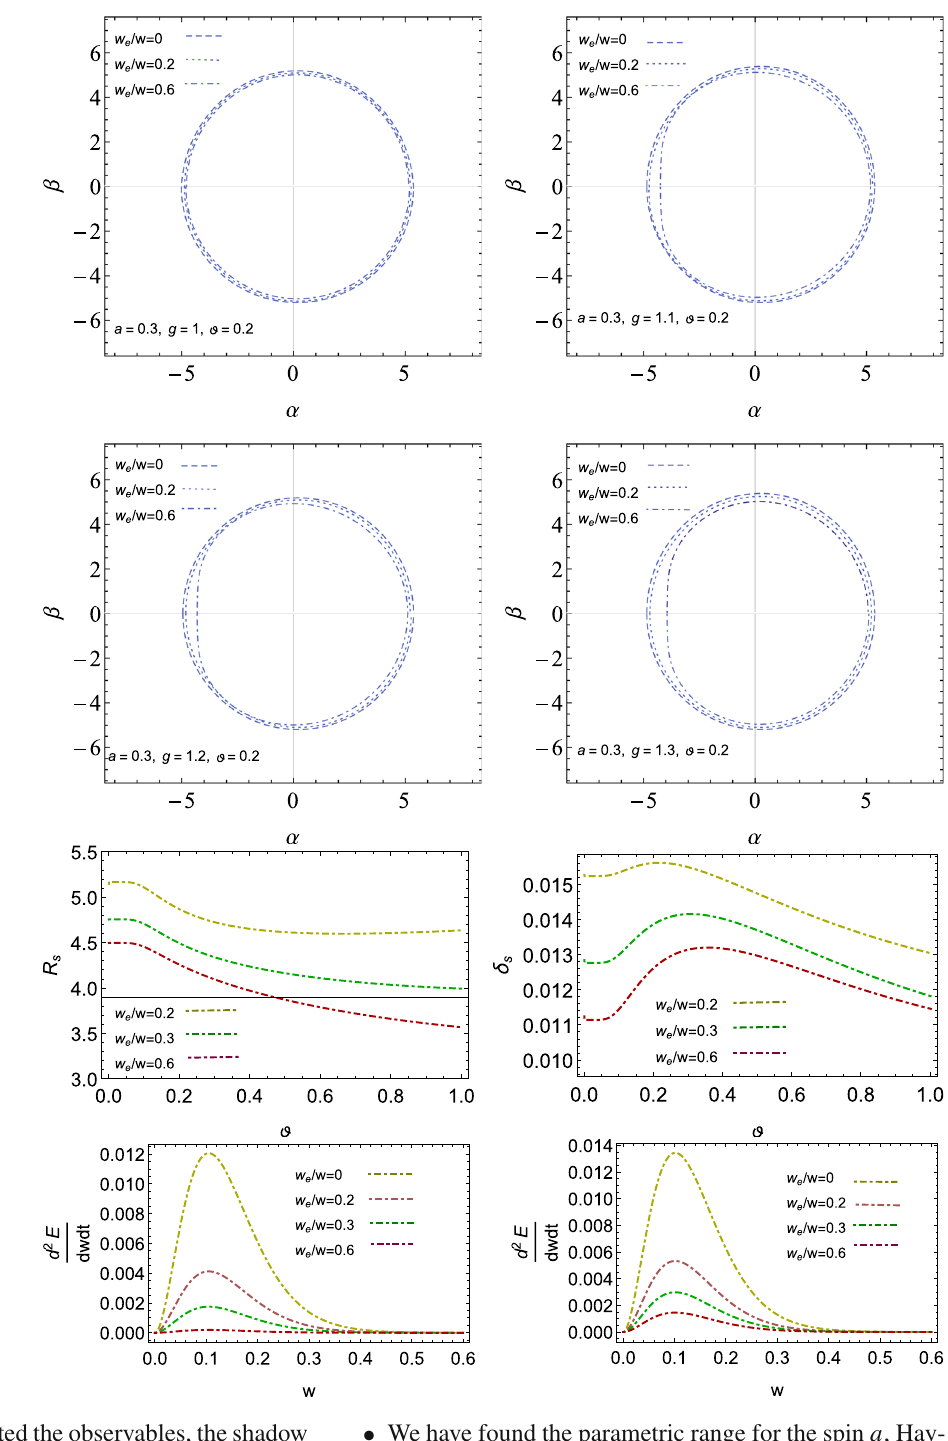
Fig. 7 Shadow of NC rotating Hayward BH with the effect of plasma